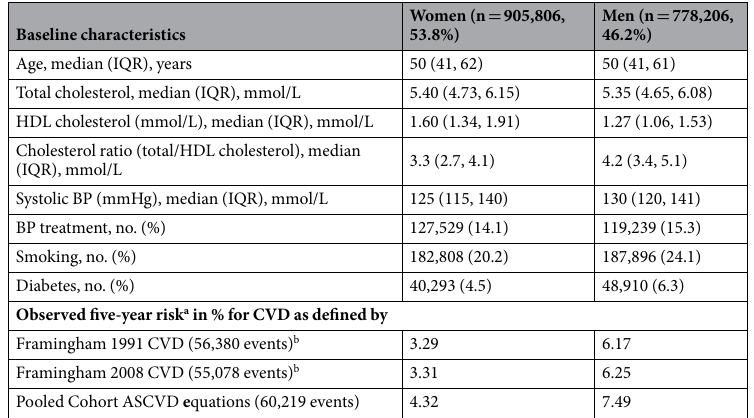
Table 1. Baseline characteristics of 1,684,012 individuals in the study cohort. Abbreviations: ASCVD, atherosclerotic cardiovascular disease; BP, blood pressure; CVD, cardiovascular disease; HDL, high density lipoprotein, IQR, interquartile range. a Kaplan-Meier estimate. b The two Framingham equations have slightly different inclusion/exclusion criteria (see Supplementary Table S2a,b). Individuals attending health-screenings between 1/2009 and 3/2014, aged 30 to 79, without a history of CVD, and their observed five-year general and atherosclerotic CVD risk. Baseline characteristics of individuals in the training set (n = 1,122,632) compared to individuals in the test set (n = 561,380) are almost identical (Supplementary Table